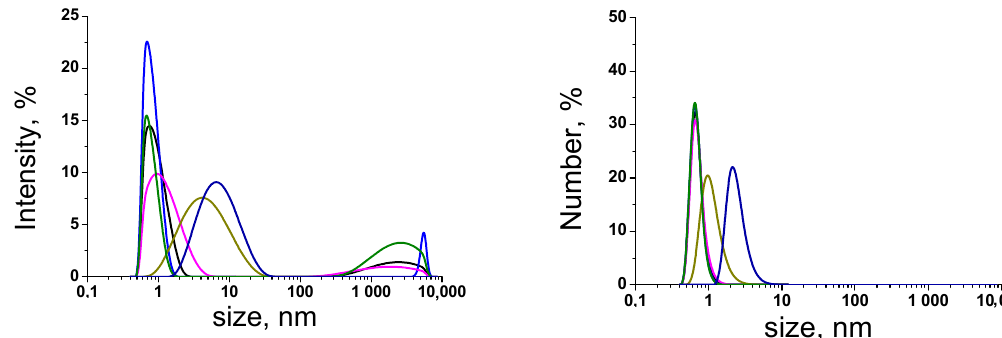
Figure 2. Some consecutive measurements of a particle size distribution by a light scattering intensity (left) and by number (right) in 0.10 mol ∙ L ‒ 1 CaCl 2 stock solution (Sample type B), detected by DLS; the swamp green (first scan), blue, pink, brown, dark blue, dark brown (last scan) bands correspond to the sequential measurements (scans), taken with 30 s delay one after another.